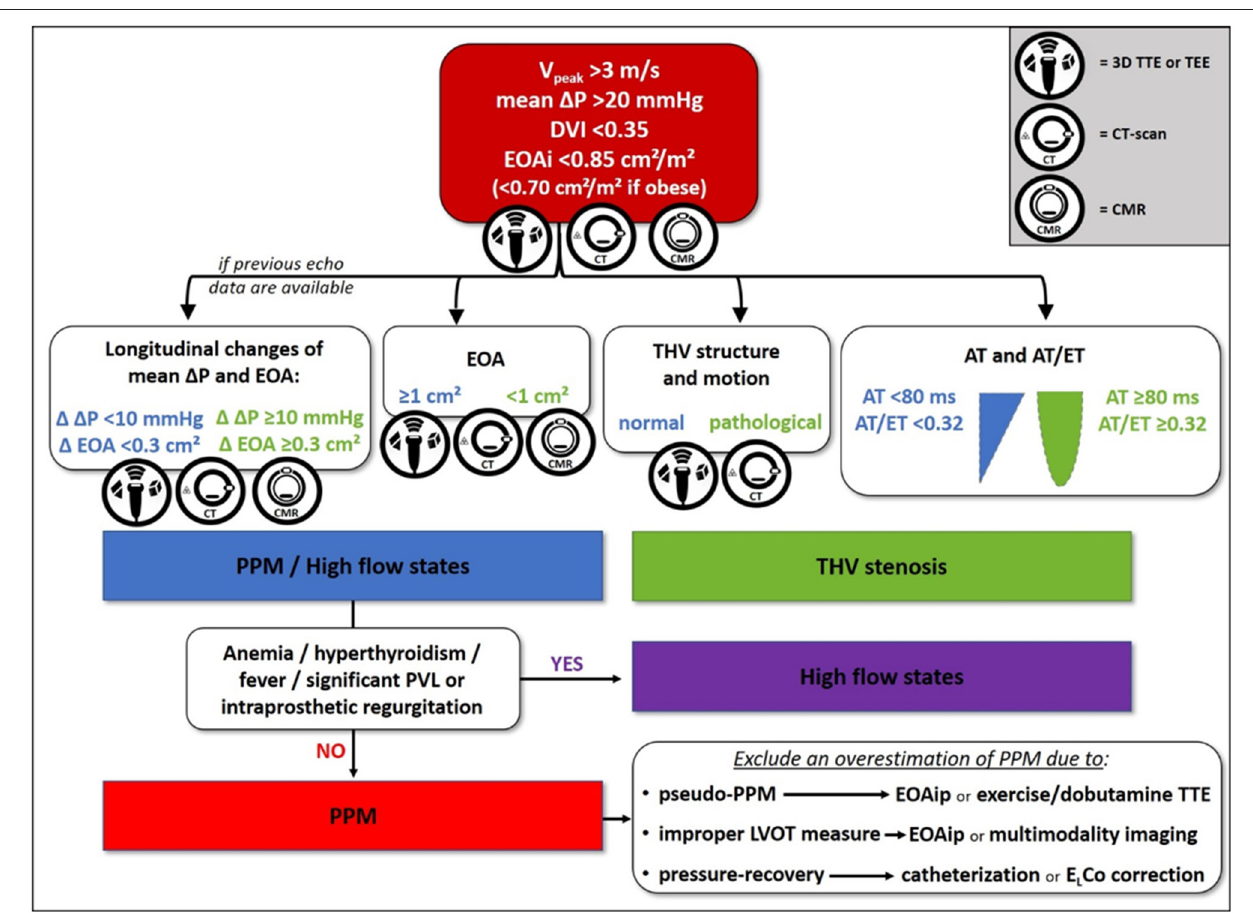
FIGURE 1 | Proposed flowchart for differential diagnosis between high-flow states, transcatheter heart valve (THV) stenosis, and prosthesis-patient mismatch (PPM). 3D, three-dimensional; AT, acceleration time; CMR, cardiac magnetic resonance; CT, computed tomography; 1 , variation; 1 P, pressure gradient; DVI, Doppler velocity index; EOA, effective orifice area; EOAi, indexed effective orifice area; EOAip, predicted indexed effective orifice area; ELCo, energy loss coefficient; ET, ejection time; LVOT, left ventricular outflow tract; PPM, prosthesis-patient mismatch; PVL, paravalvular leak; TEE, transesophageal echocardiography; THV, transcatheter heart valve; TTE, transthoracic echocardiography; V,